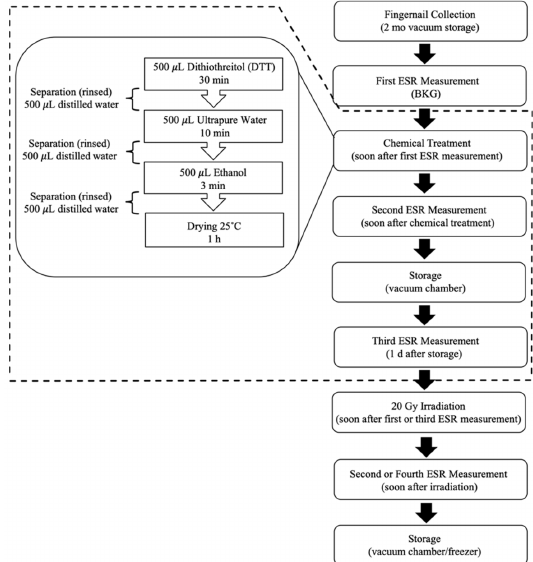
Figure 1. Flowchart of the stages of fingernail sample preparation and electron spin resonance (ESR) measurements. Two experimental setups were employed—one “with chemical treatment” process including application of dithiothreitol (DTT) and the other “without chemical treatment” process without DTT. The part indicated with a dashed line in the above flow chart was omitted in the “without chemical treatment”